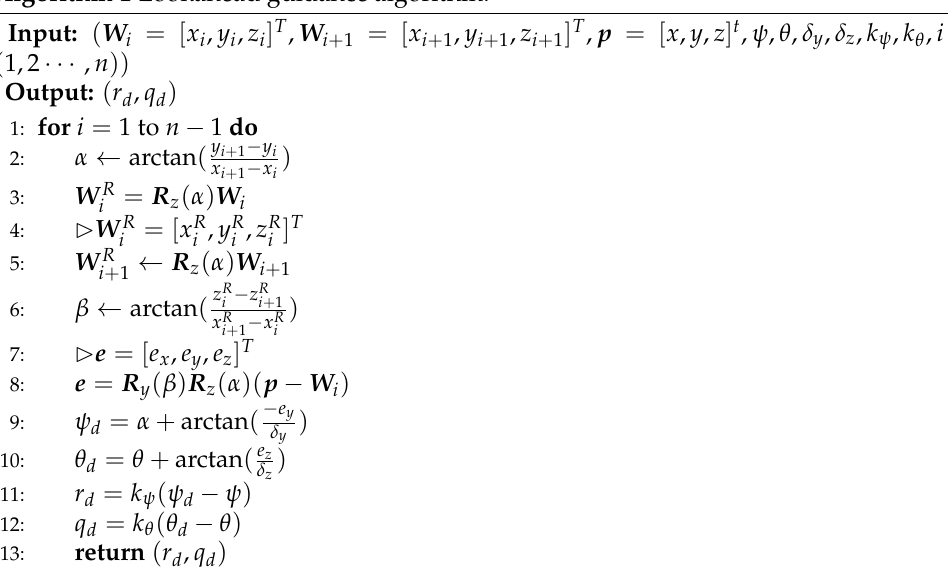
Algorithm 1 Lookahead guidance